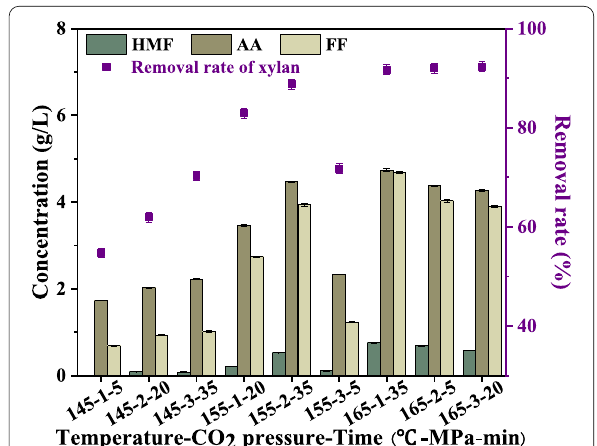
Fig. 2 The concentration of by-products and removal rate of xylan under different treatment